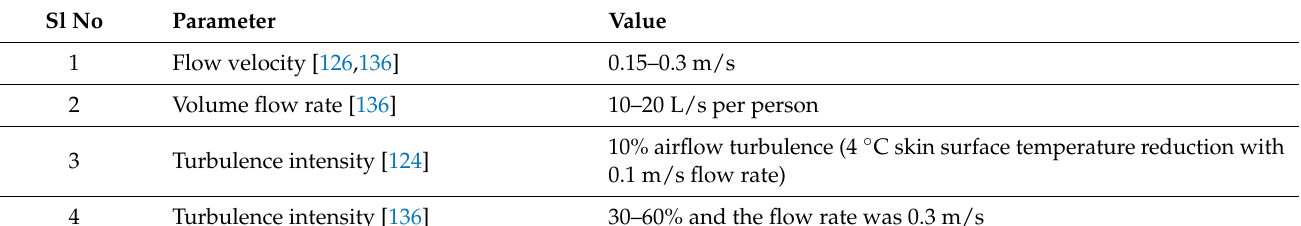
Table 11. Recommended flow conditions for